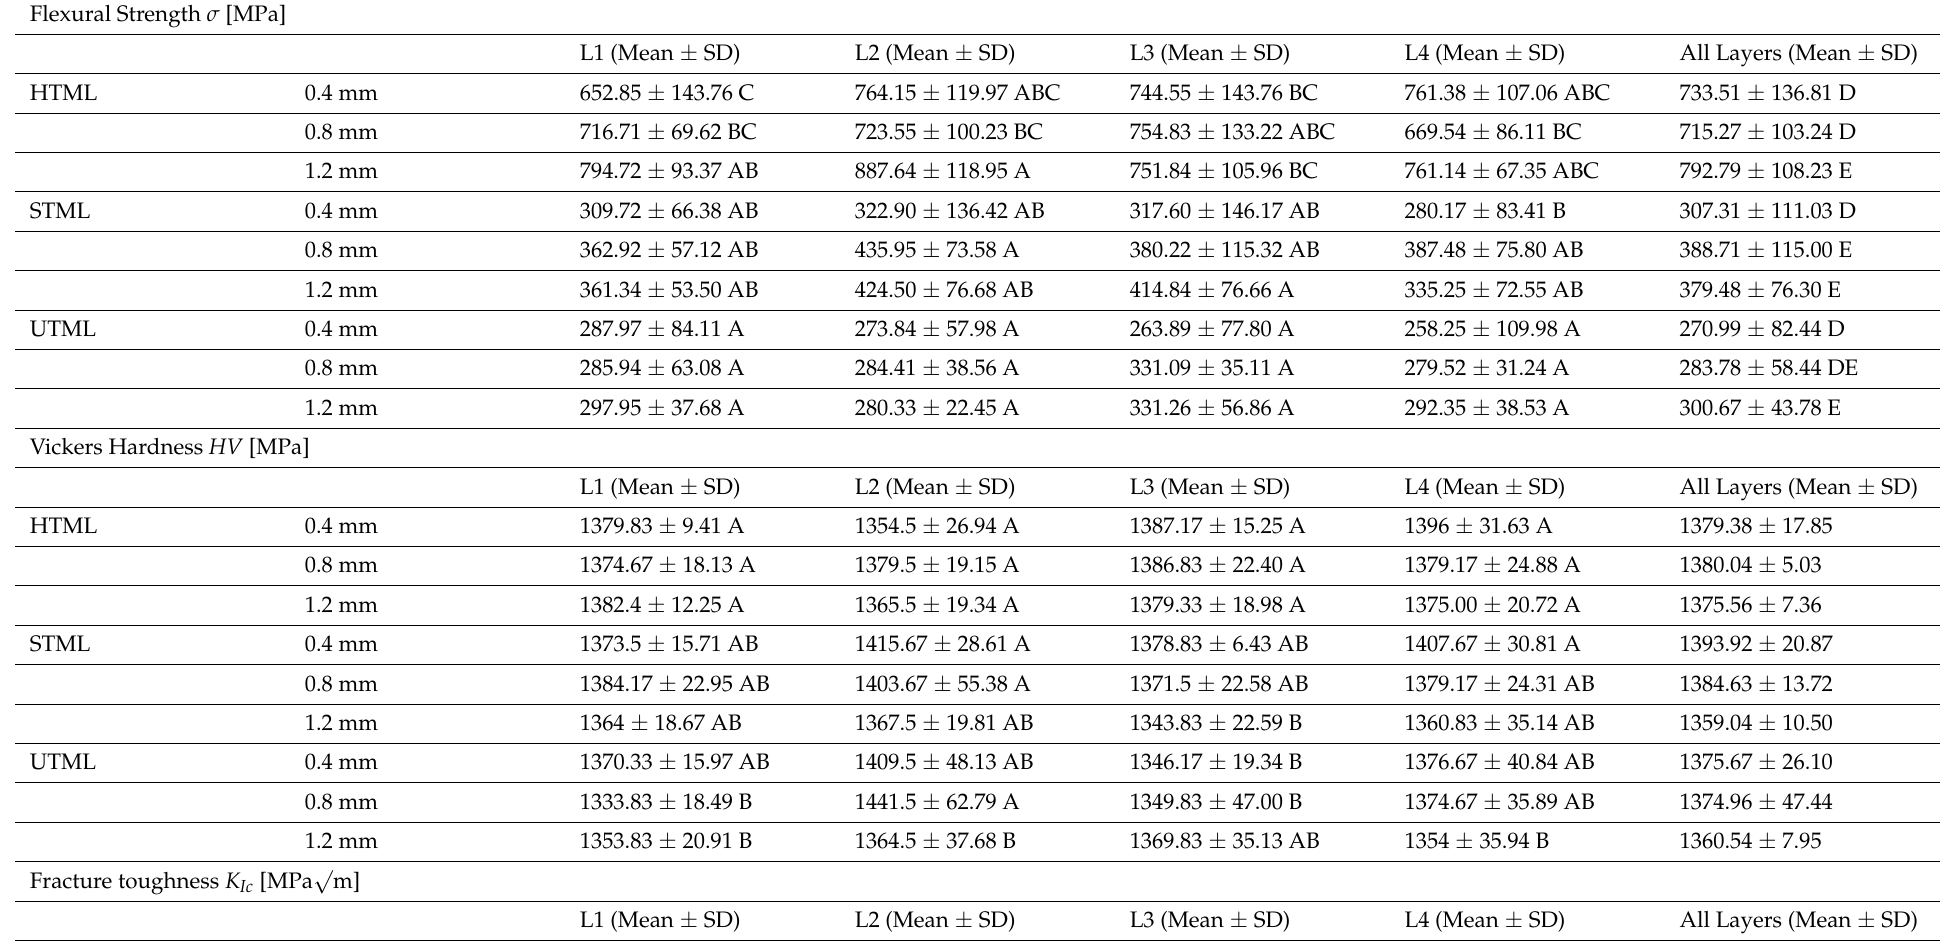
Table 2. Descriptive non-parametric statistics (Mean ± SD) for flexural strength σ , Vickers hardness HV and fracture toughness K Ic for all tested